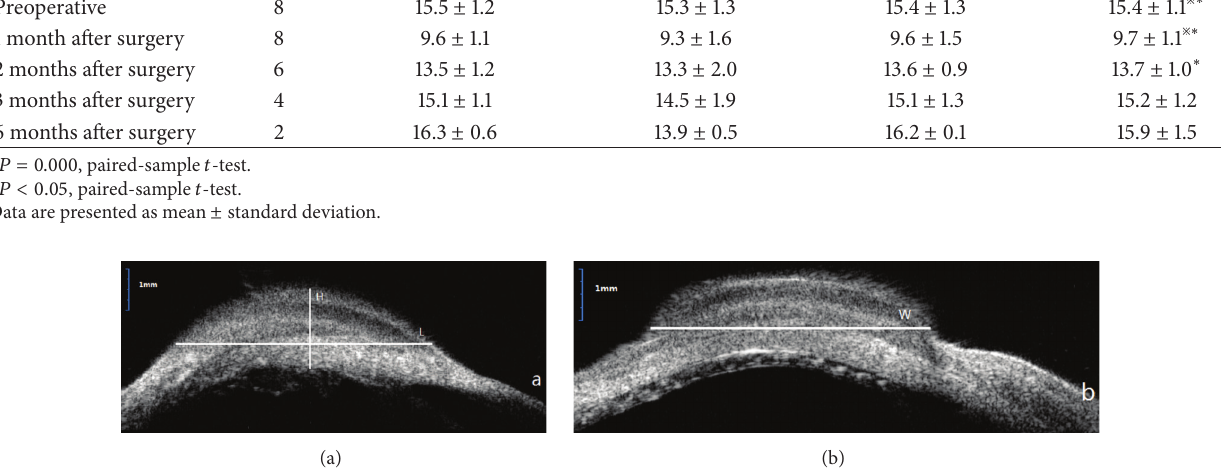
Figure 2: Imaging of UBM examination. (a) Horizontal section of the filtering bleb. (b) Vertical section of the filtering